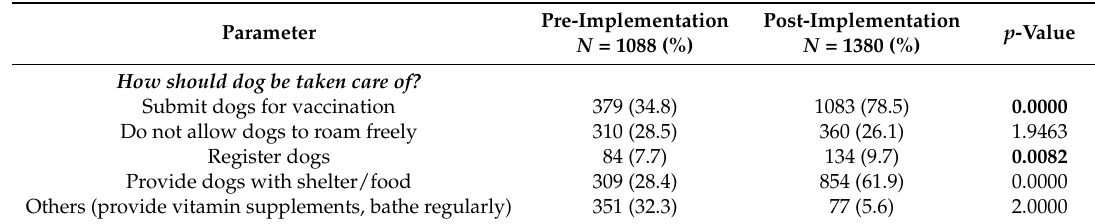
Table 6. Duties of pet owners towards